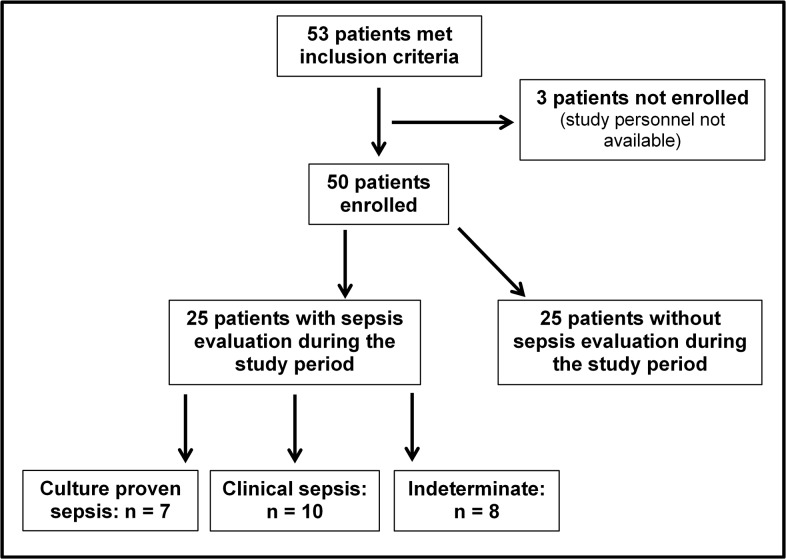
Flow diagram of group allocation of the 50 infants enrolled in the study.During the study period (i.e. day of life 4 until day of life 28), 25 infants were evaluated for sepsis. Infants with septicemia represent the culture positive group (n = 7). Infants with clinical features of infection, a negative blood culture and antibiotic treatment for at least 5 days were allocated to the clinical sepsis group (n = 10) and infants with evaluation for sepsis who were subsequently proven not to be infected were allocated to the indeterminate group (n = 8). The control group consisted of the remaining 25 infants without sepsis evaluation.